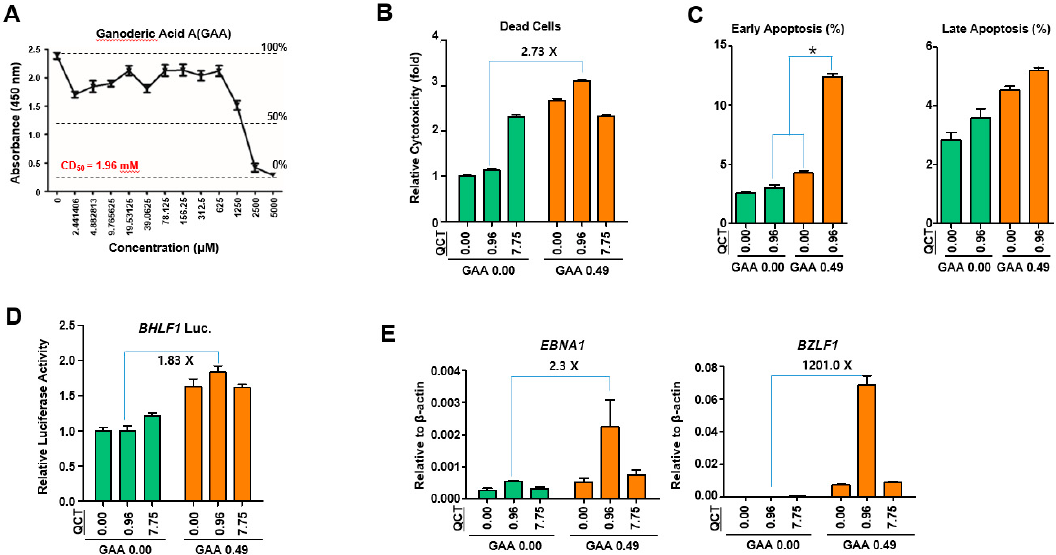
Figure 7. Cotreatment with GAA and QCT decreased cell viability. ( A ) The measurement of the CD 50 of GAA in SNU719 cells. The CD 50 value of GAA was 1.96 mM. ( B ) The determination of the cytotoxic e ff ects of the cotreatment with 0.49 mM GAA and various concentrations (0 ~ 7.75 µ M) of QCT in SNU719 cells. ( C ) The determination of the apoptotic e ff ects of the cotreatment of 0.49 mM GAA and 0.96 µ M QCT. ( D ) The determination of the e ff ects of the cotreatment with GLE and QCT on the EBV lytic reactivation. SNU719-BHLF1 luciferase cells were treated with 0.49 mM GAA and various concentrations (0 ~ 7.75 µ M) of QCT. ( E ) The determination of the e ff ects of various concentrations of QCT + GAA (0.49 mM) on EBV gene expression. GAA and QCT: Ganoderic acid A and quercetin, respectively.